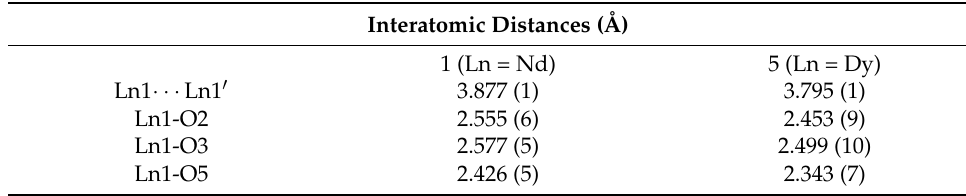
Figure 7. Intermolecular interactions in the crystal structure of complex 6 . ( a ) 2D arrangement of the dinuclear molecules parallel to the (100) plane. Thick dashed yellow lines indicate the C16-Hc(C16) … O2 (2.46 Å) H bond, where C16 is the methyl carbon atom of the crystallographically unique η 1 : η 2 : μ 2 (2.12) acetato group; ( b ) stacking of layers parallel to the α crystallographic axis. Thick dashed red-violet lines represent the C4-H(C4) … O3 (2.35 Å), C6-H(C6) … O2 (2.44 Å) and C14-H C (C14) … O7 (2.58 Å) H bonds; C4 and C6 are aromatic carbon atoms of the mepaoH ligand. The distances and angles for the H bonds, as well as the symmetry operations are listed in Table S4. Table 1. Selected interatomic distances (Å) and angles ( ◦ ) for complexes 1 and 5 a